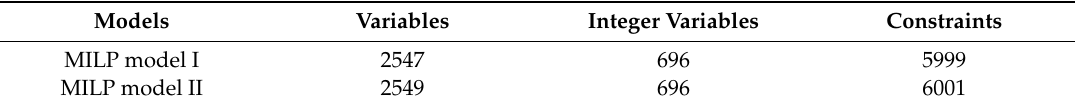
Table 2. Computational scale of the routing problem formulated by two MILP